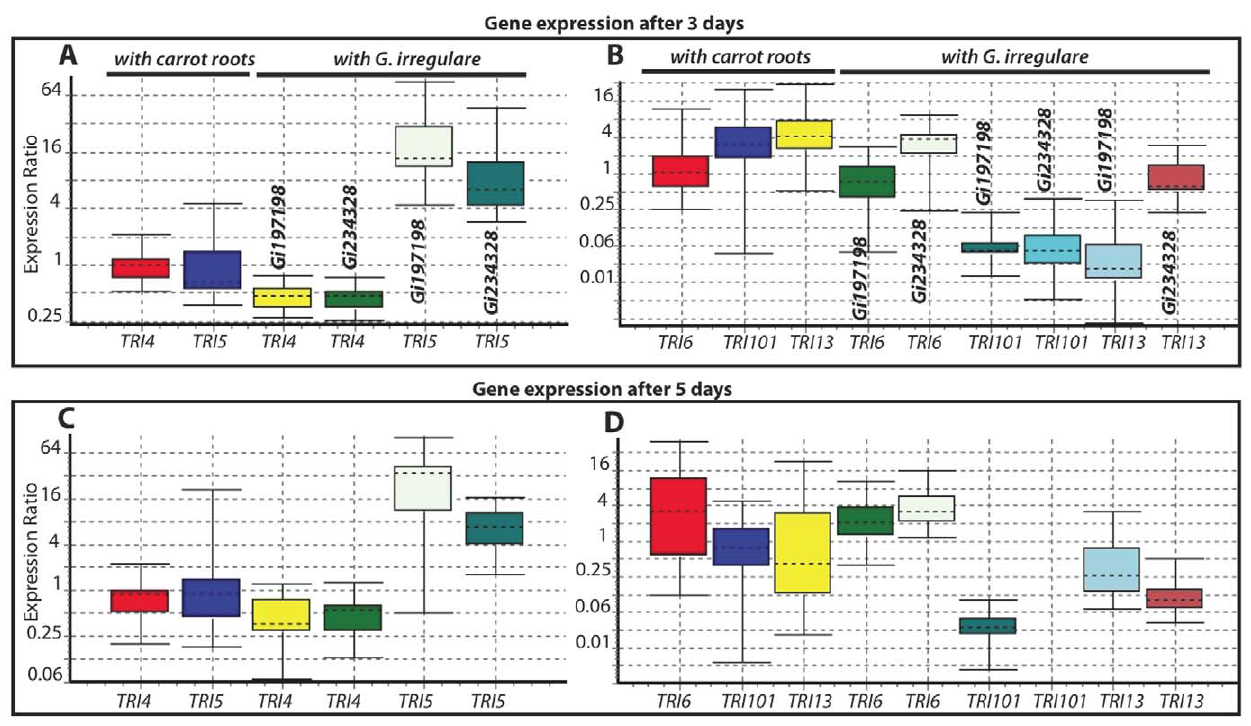
Figure 4. Relative expression patterns of TRI4,TRI5,TRI6,TRI101 and TRI13 genes from F.sambucinum compared with two reference genes ß-tubulin and EF-1 a . Relative expression patterns of TRI genes of F. sambucinum after 3 days (A and B) and 5 days (C and D) of confrontation either with carrot roots lacking AMF, or with G. irregulare colonized carrot roots. Panels A and C show relative expression patterns of TRI4 and TRI5 for F. sambucinum confronted with carrot roots and against G. irregulare isolates DAOM-197198 (Gi197198) and DAOM-234328 (Gi234328), respectively. Panels B and D show relative expression patterns of TRI6 , TRI101 and TRI13 of F. sambucinum against carrot roots and G. irregulare isolates DAOM-197198 (Gi197198) and DAOM-234328 (Gi234328), resperctively.